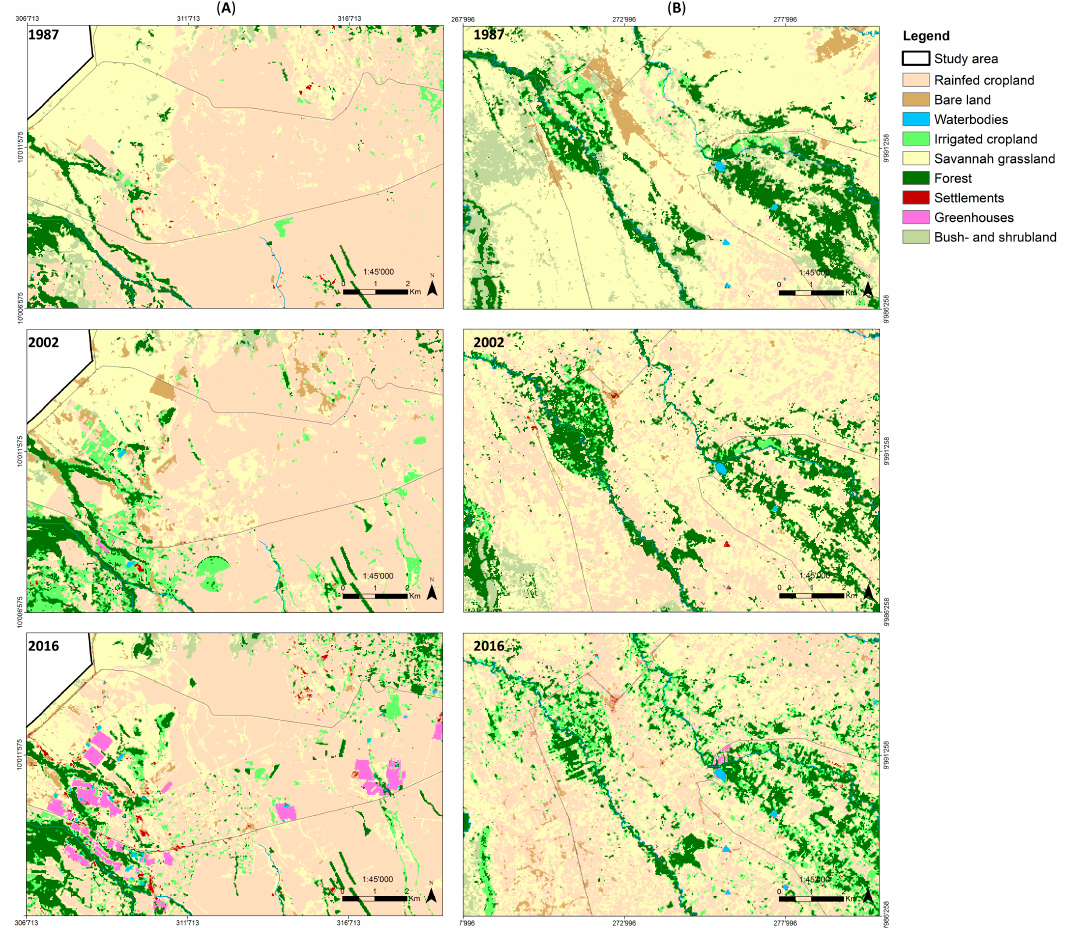
Figure 4. Two subsets of the land cover and land use classifications for 1987, 2002, and 2016 showing ( A ) the development of greenhouses and irrigation water reservoirs east of Timau, and ( B ) the conversion of savannah grassland, forests mostly along rivers, and wetlands northwest of Naro Moru, along the Naro Moru and Burguret rivers to rainfed and irrigated cropland (map projection: UTM 37S).